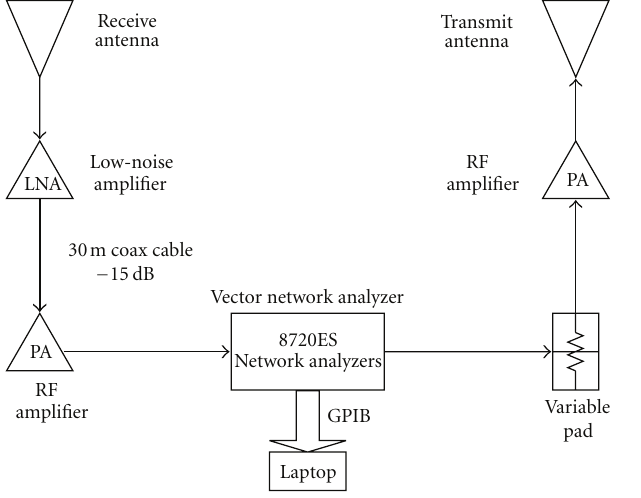
Figure 1: Block diagram of the measurement system.